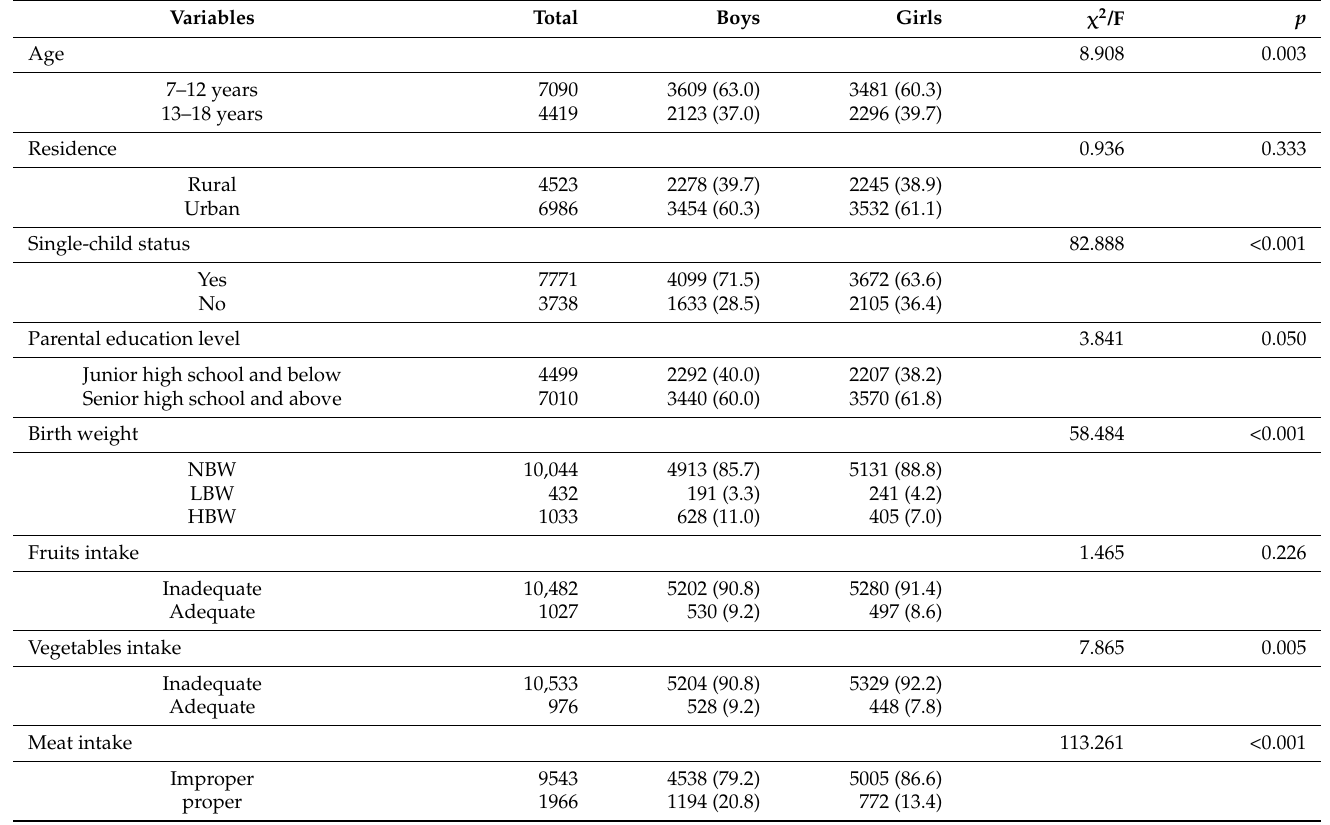
Table 1. Demographic characteristics of eligible children and adolescents and their parents stratified by